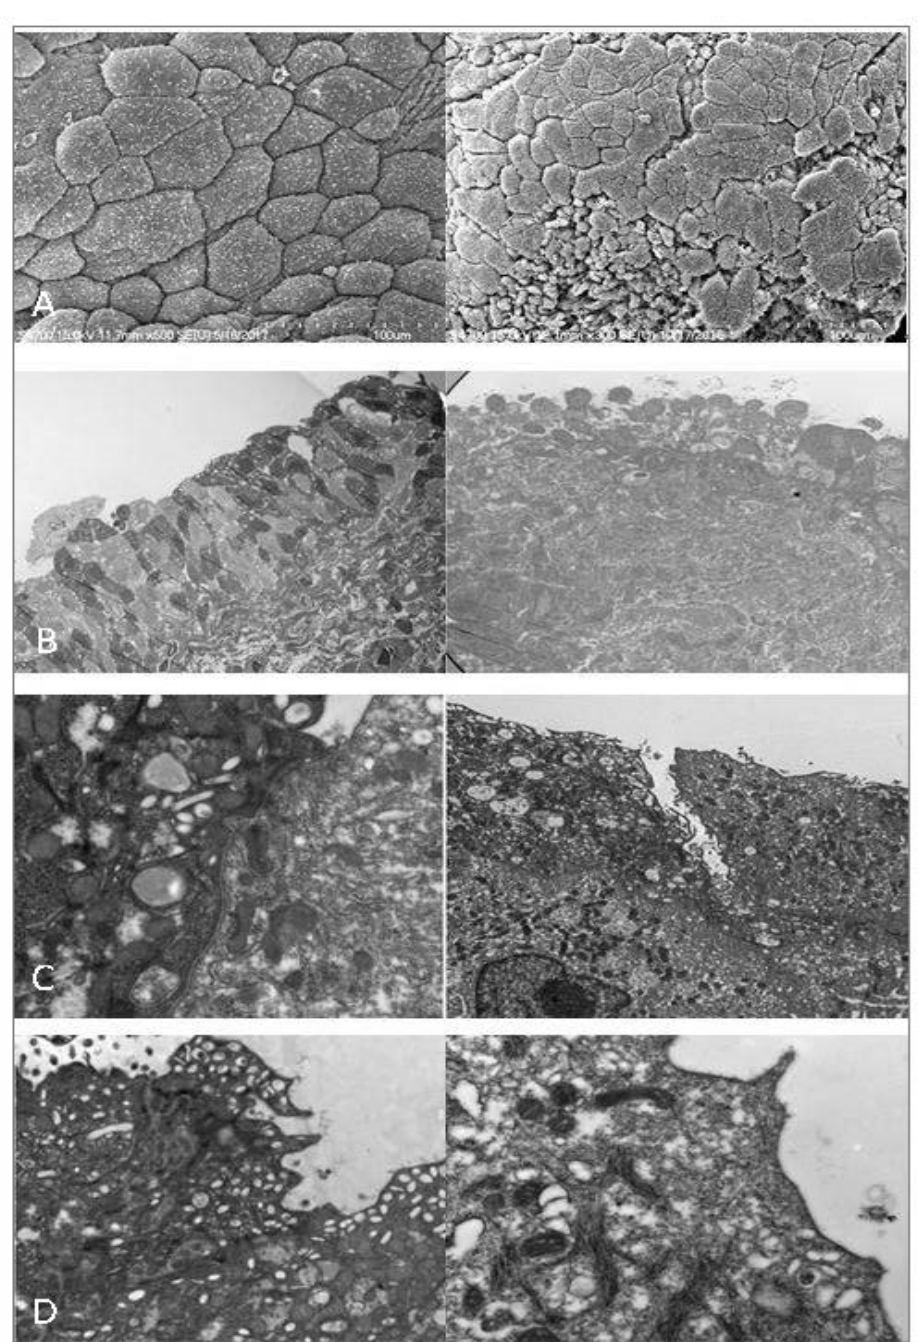
Figure 2. The electron microscopic findings in ( left ) normal bladder urothelium and ( right ) the bladder from a patient with interstitial cystitis/bladder pain syndrome (IC/BPS). ( A ) Scanning electron microscopy images of normal umbrella cells vs. pleomorphism in IC/BPS. ( B ) Transmission electron microscopy images of normal urothelium vs. defects in urothelial cell layers in IC/BPS. ( C ) Normal umbrella cell tight junction vs. defective tight junction in IC/BPS. ( D ) Normal surface microvilli and vesicles vs. the loss of microvilli and vesicles in an IC/BPS bladder.